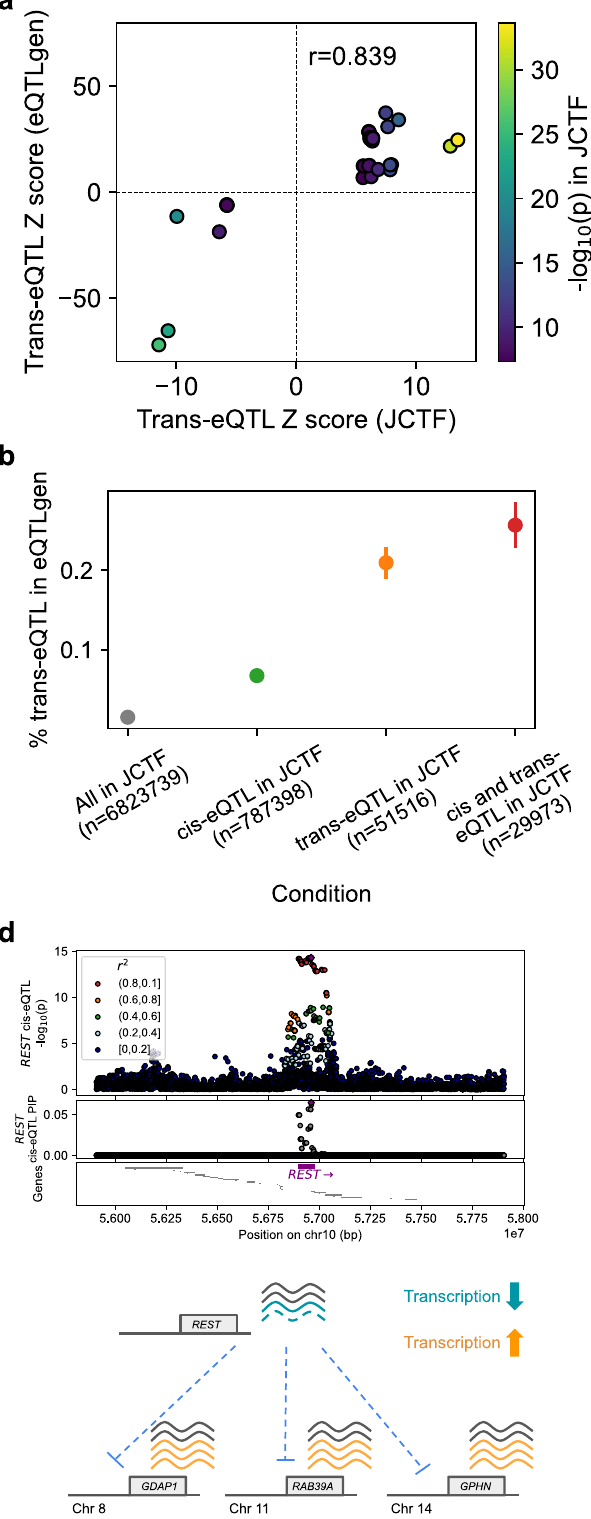
Nature Communications| (2022)